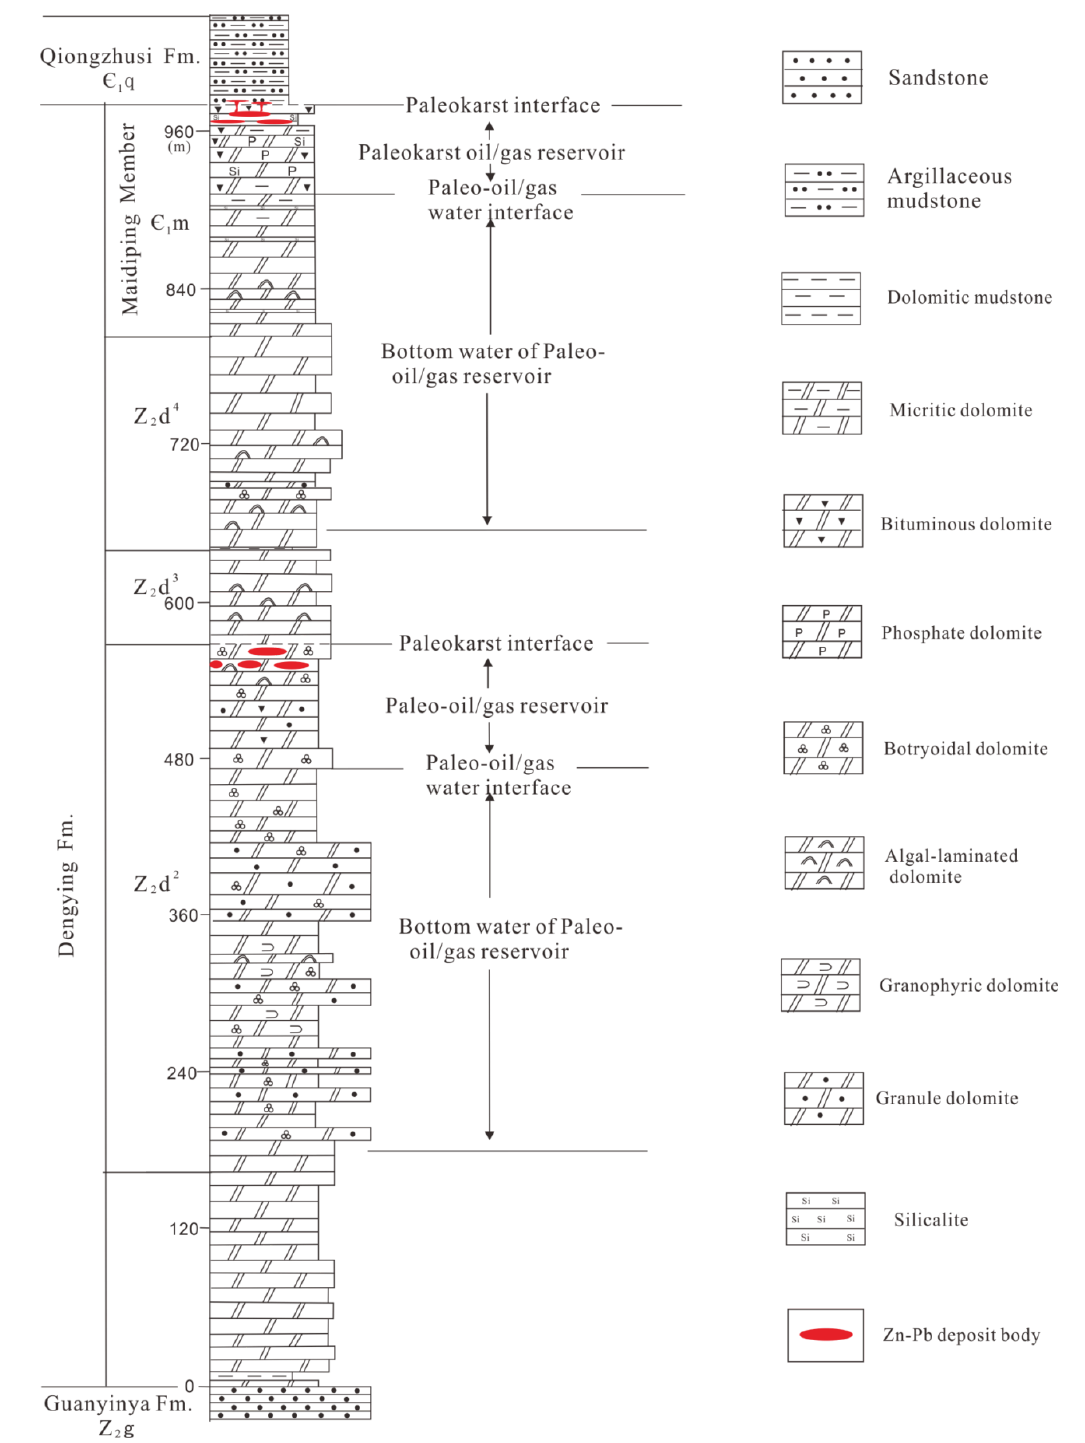
Figure 2. Lithological column and distribution of Zn – Pb deposits and oil/gas reservoirs.